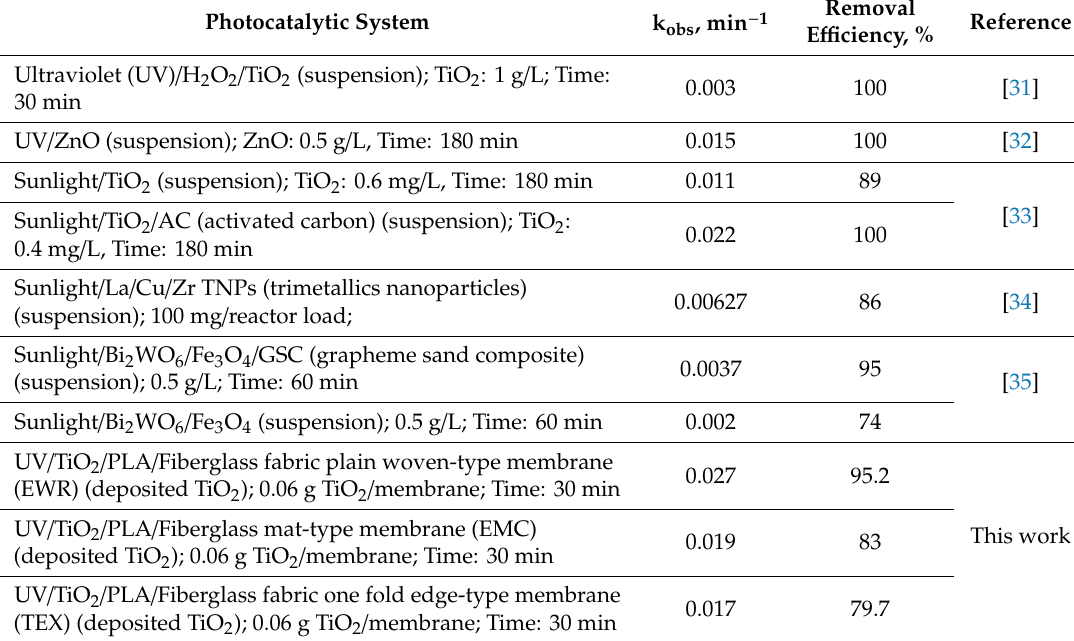
Table 5. Performance of di ff erent photocatalytic systems for ampicillin removal from aqueous solutions. The data presented correspond to the best operating conditions of the photocatalytic